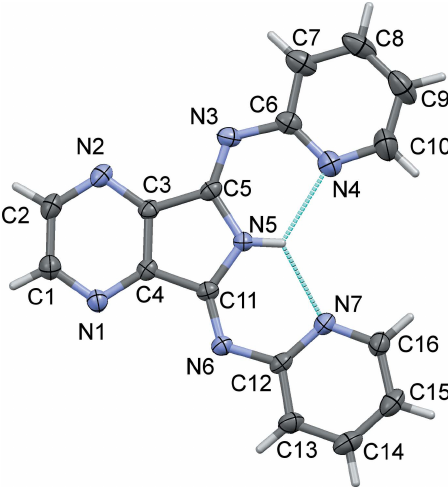
Figure 1 The molecular structure of the title compound, with the atom labelling and displacement ellipsoids drawn at the 50% probability level. The intramolecular three-centre (bifurcated) N—H (cid:2)(cid:2)(cid:2) N hydrogen bonds are shown as dashed lines (see Table 1).